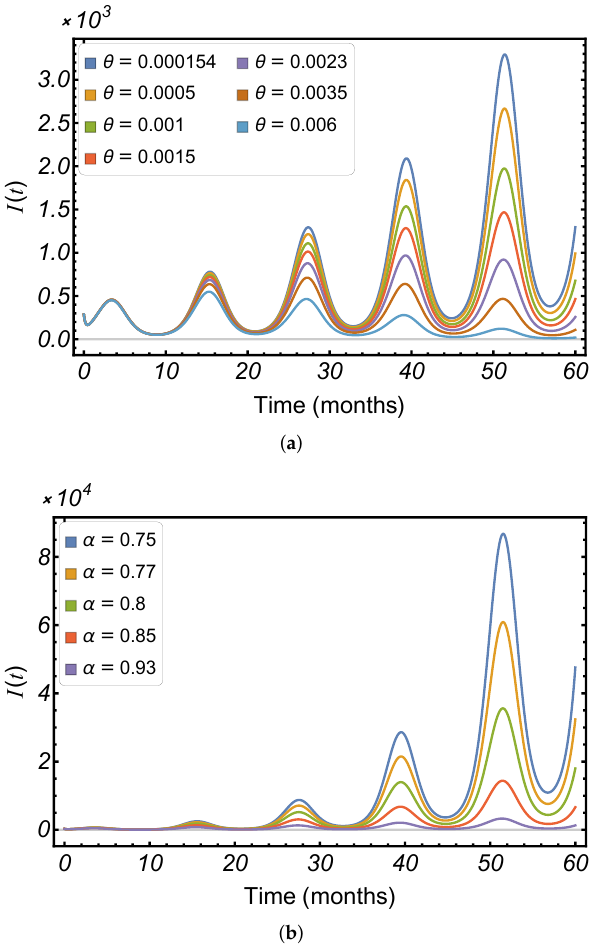
Figure 7. Infectious population with differing values of ( a ) the vaccine coverage rate θ and ( b ) the vaccine efficacy α , utilizing the parameter values listed in Table 2.